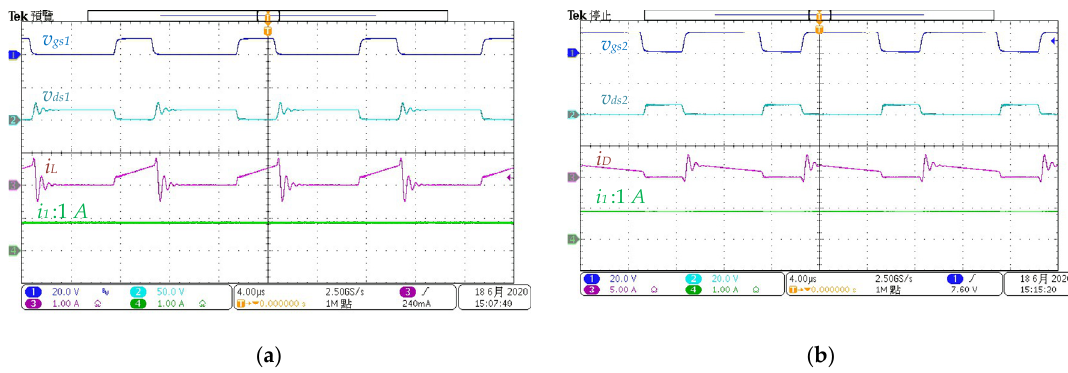
Figure 9. Hardware waveforms of the developed prototype ( a ) high side ( b ) low side.